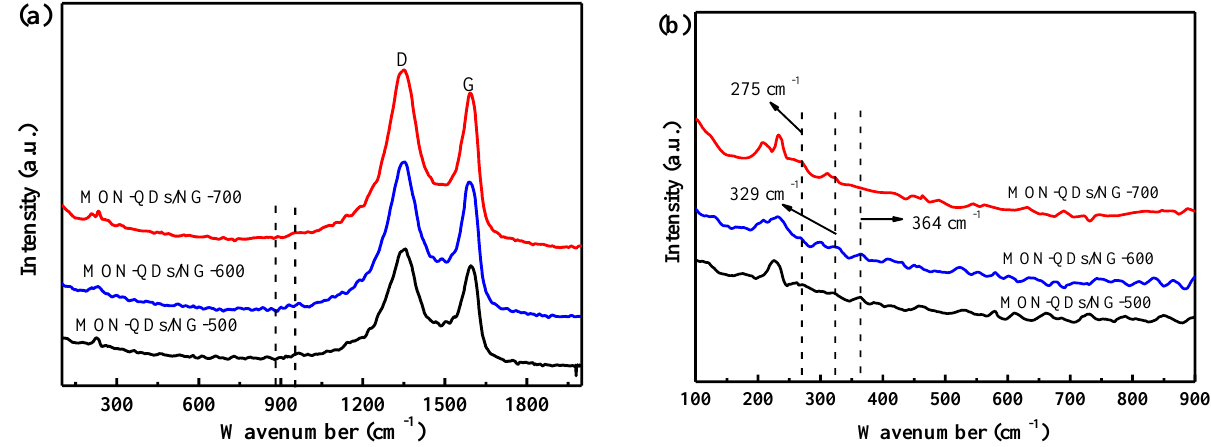
Figure 2. Raman spectra of MON-QD/NG at different calcination temperatures ( a , b ).